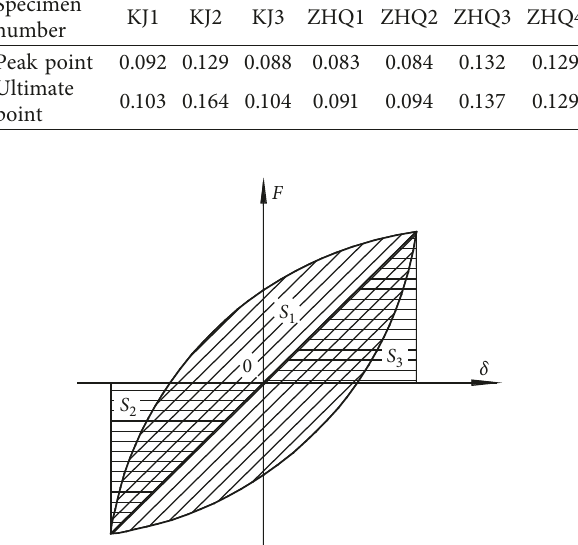
Figure 16: Calculation of equivalent viscous damping coefficient.